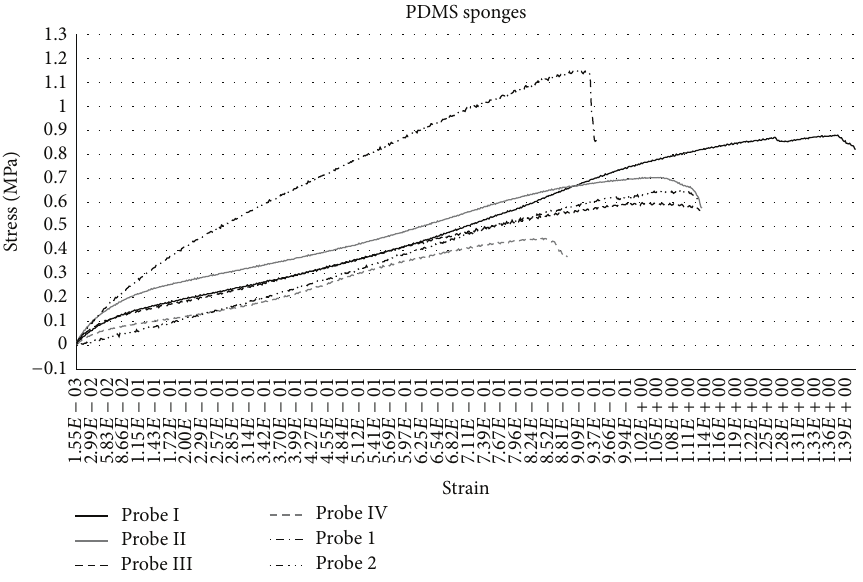
Figure 6: Comparative mechanical performance of the PDMS sponges